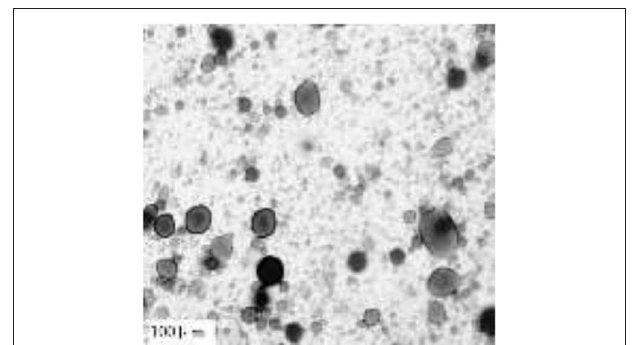
FIGURE 8 | Nanomaterial emulsion microscope